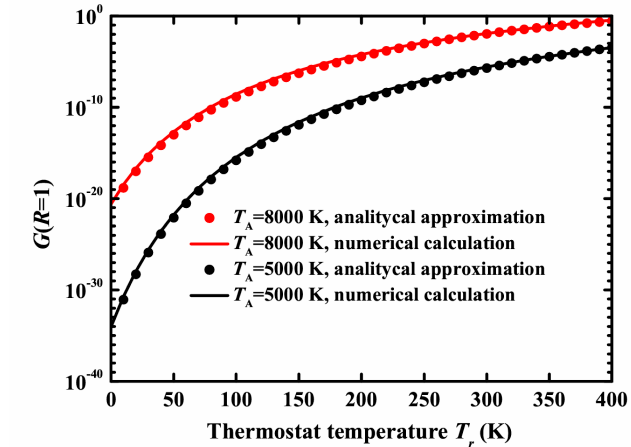
Figure 6. The integral G ( R = 1) as a function of thermostat temperature for T A = 8000 K (black color) and T A = 5000 K (red color). The points show numerical calculations using Equation (16), and the line shows the approximation by Equation (19). The radius of a gold nanoparticle is r p = 20